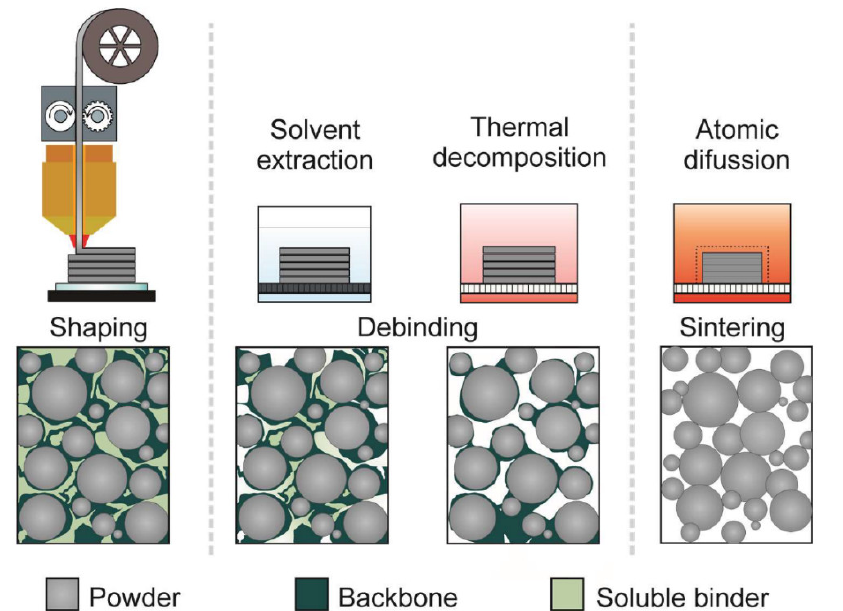
Figure 7. Schematic representation of the shaping, debinding, and sintering (SDS) process and respective morphology of the parts for the fabrication of metal, ceramic, or metal–ceramic components. Reprinted from [30] with permission from MDPI.